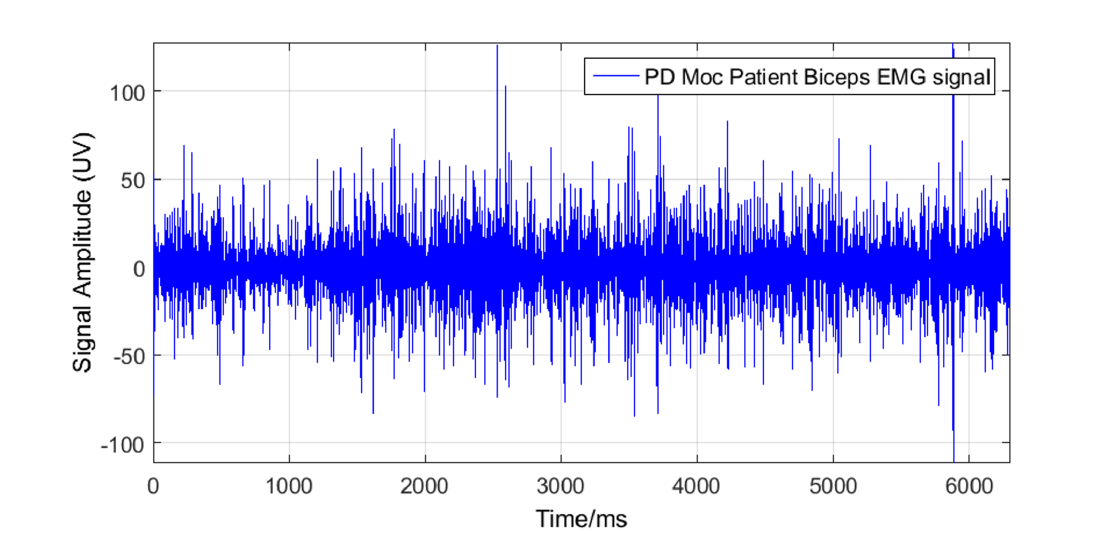
Figure 8. EMG (Biceps) signal of a PD patient.